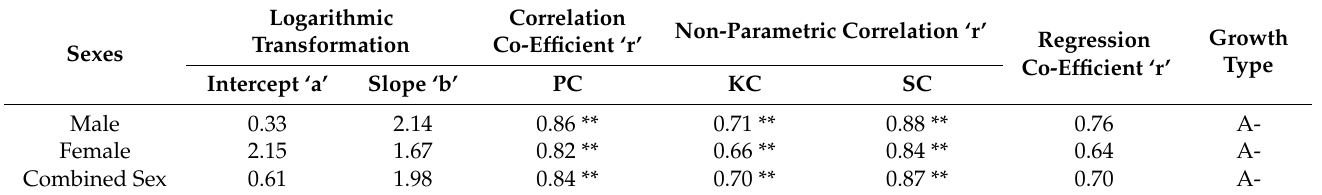
Table 1. Length-Weight Relationships {LWRs; ln (BW) = ln a + b ln (TL)} and growth type of different